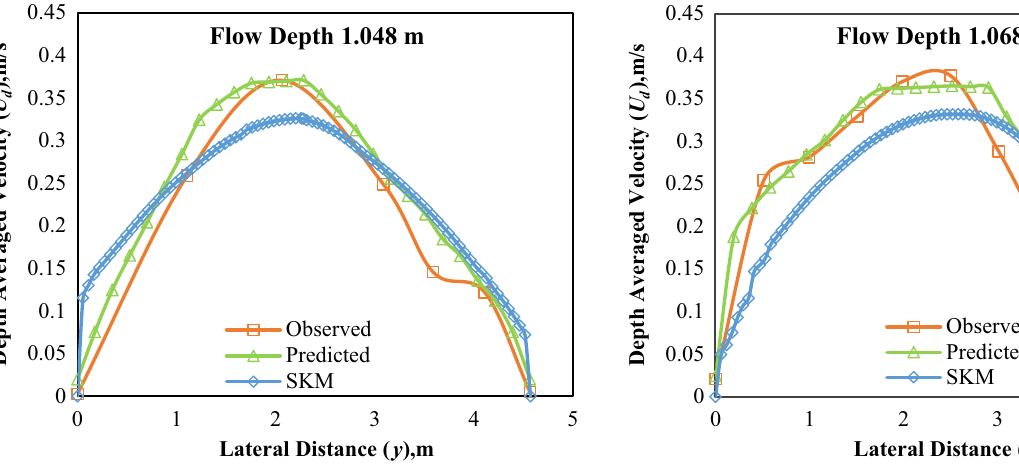
Fig. 19 Modified cross section of river Senggai equivalent to actual area